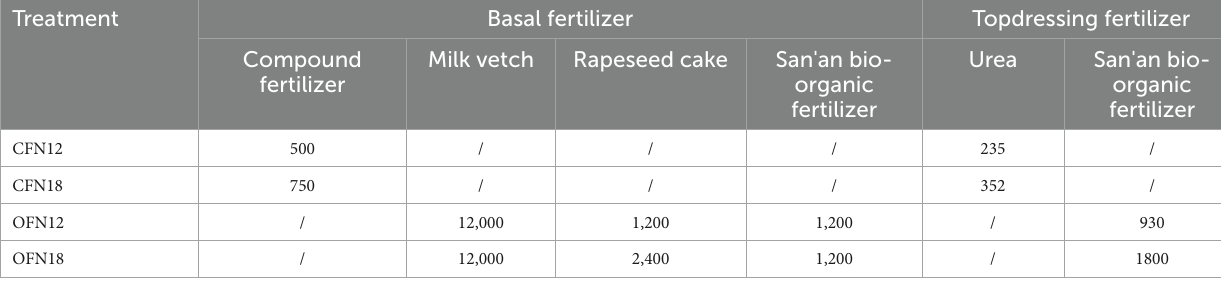
TABLE 1 Fertilizer application rates under two nitrogen levels of conventional and organic cultivation (kg·hm − 2